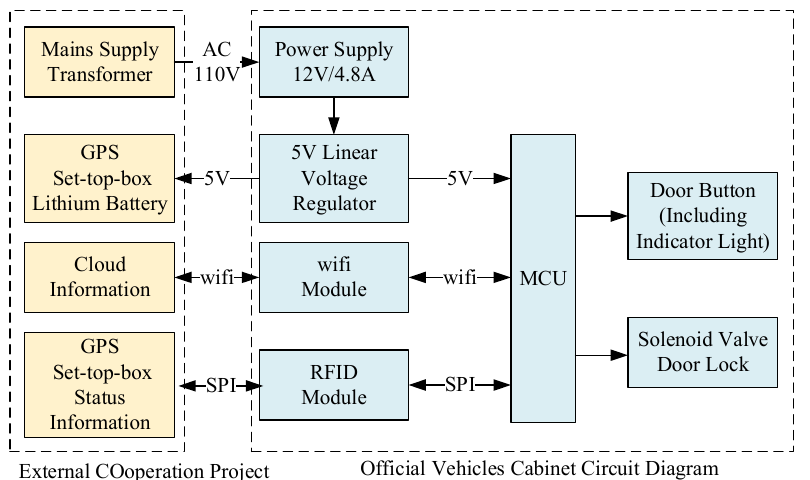
Figure 10. Architecture diagram of the key cabinet communication system.